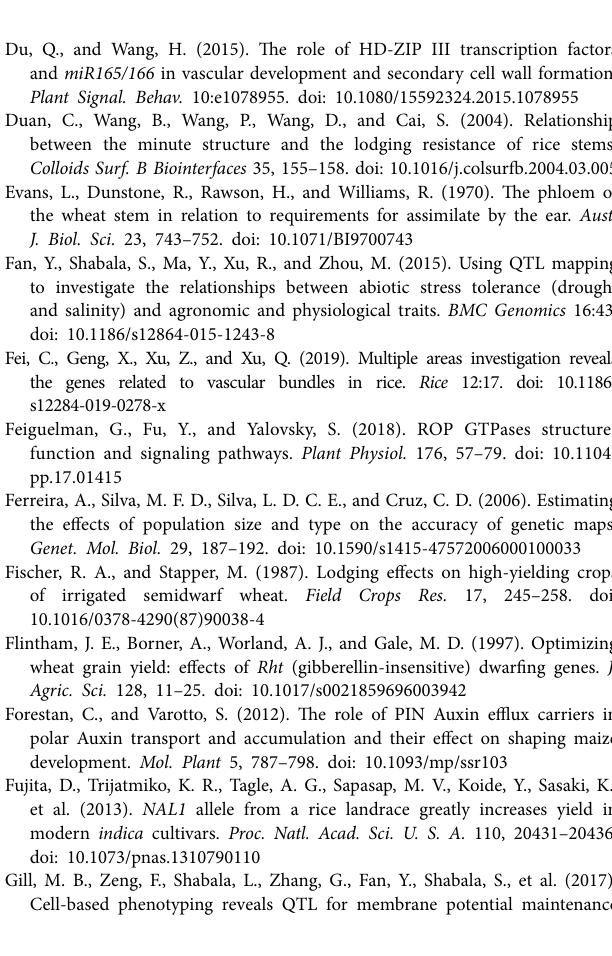
Supplementary Figure S1 | Collinearity of marker orders between the genetic and reported consensus maps. Supplementary Figure S2 | Phenotypic distributions of two yield-related traits and PH in different environments. RN: the number of the spikelet; PW: panicle weight; PH: plant height. Supplementary Figure S3 | Correlations between lodging-related traits and yield-related traits across different environments. The number in the middle of the cell is the correlation coefficient; “*,” “**,” and “***” refer to significant correlations ( p < 0.05, p < 0.01, and p < 0.001). VB: the number of big vascular bundle; SD: stem diameter; SWT: stem wall thickness; RN: the number of the spikelet; PW: panicle weight; PH: plant height. Supplementary Table S1 | Phenotypic data of wheat DH population from Baiqimai and Neixiang 5. Supplementary Table S2 | Genotypic data of wheat DH population from Baiqimai and Neixiang 5. Supplementary Table S3 | Map positions of different SNP and DArT